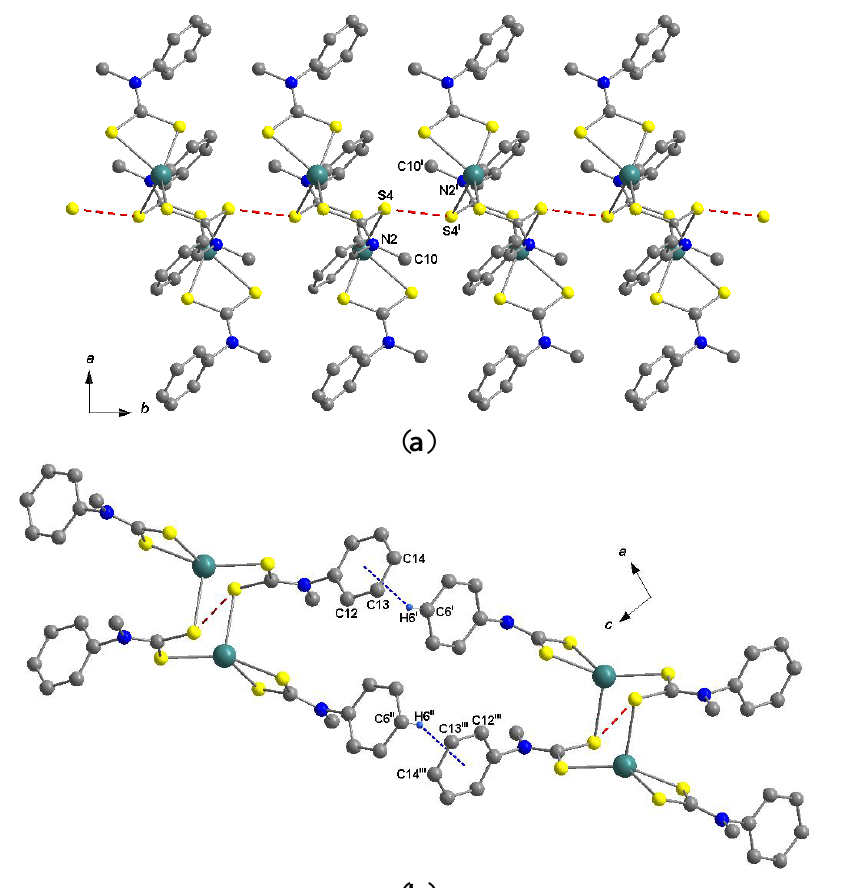
Figure 7. (a) Packing diagram of [(C interactions; (b) Packing diagram of [(C intermolecular